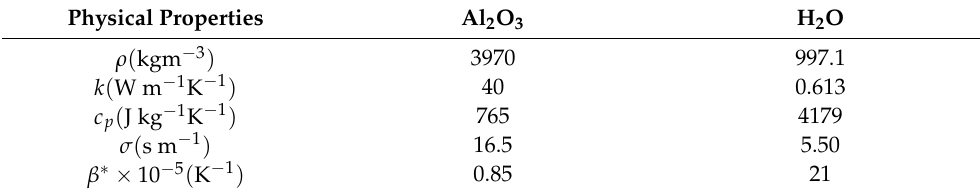
Table 1. Thermophysical properties of Al 2 O 3 and water.